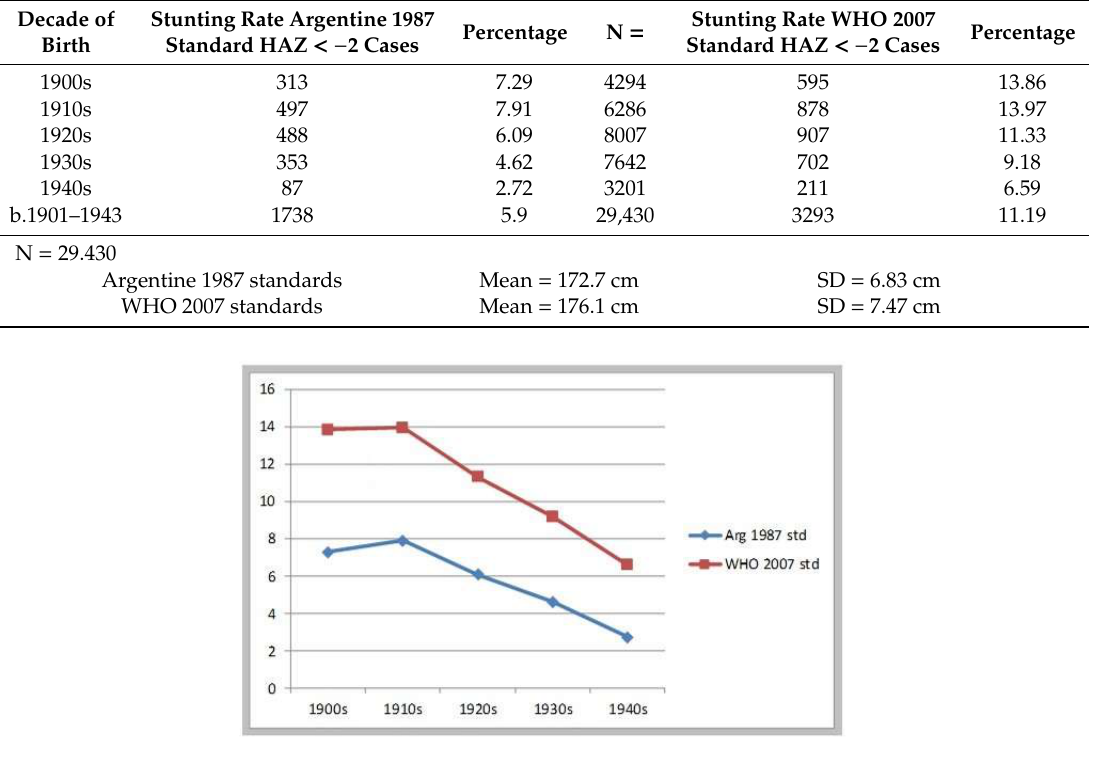
Figure 3. Evolution of moderate & severe stunting. Recruits from Regiment Patricios